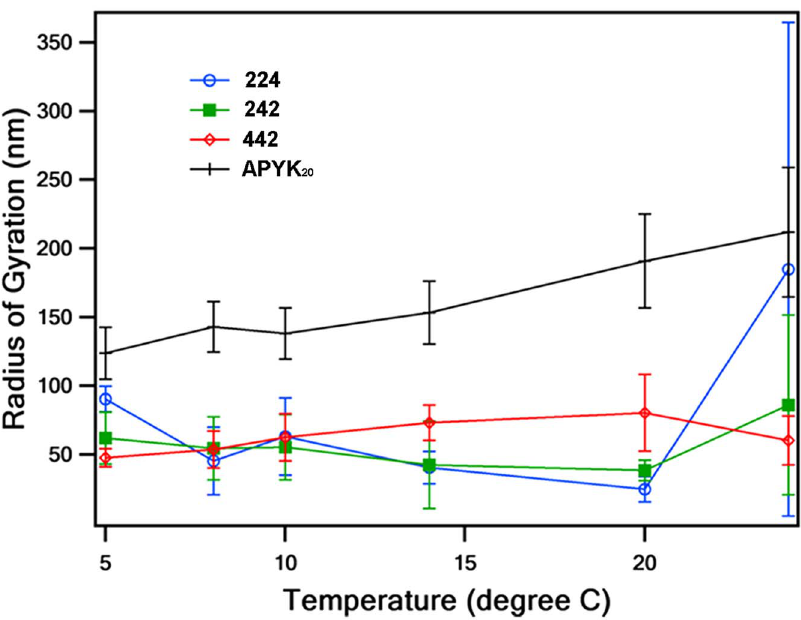
Fig. 2. Temperature and molecular radius relationship of the glycomodules. When temperature increased from 20 ˚ C to 24 ˚ C, the average radii of 224 and 242 glycomodules increased as the control extensin analog APYK20. Only 442 glycomodule had a decreased average radius when the temperature increased from 20 ˚ C to 24 ˚ C. At 24 ˚ C, the standard deviation of 224 radius was greater than that of 242, with both standard deviations much greater than that of 442. It indicates that 224 and 242 glycomodules may be responding to temperature in a broader size range at 24 ˚ C.